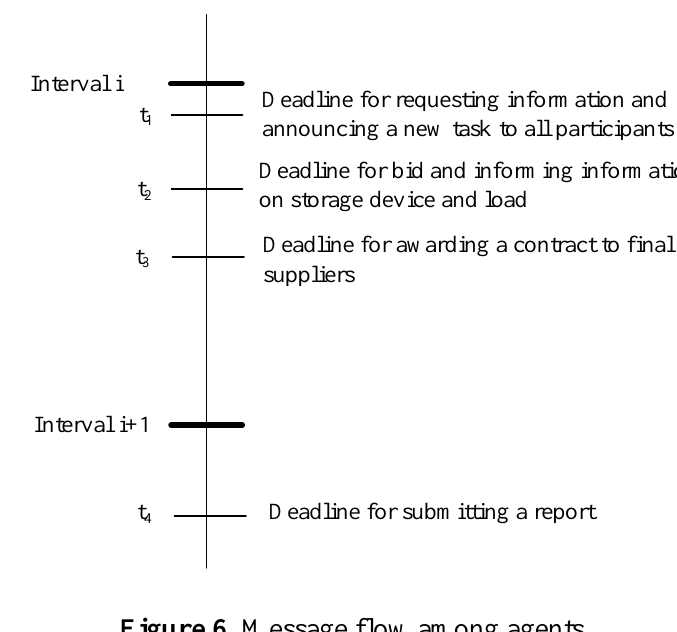
Figure 6. Message flow among